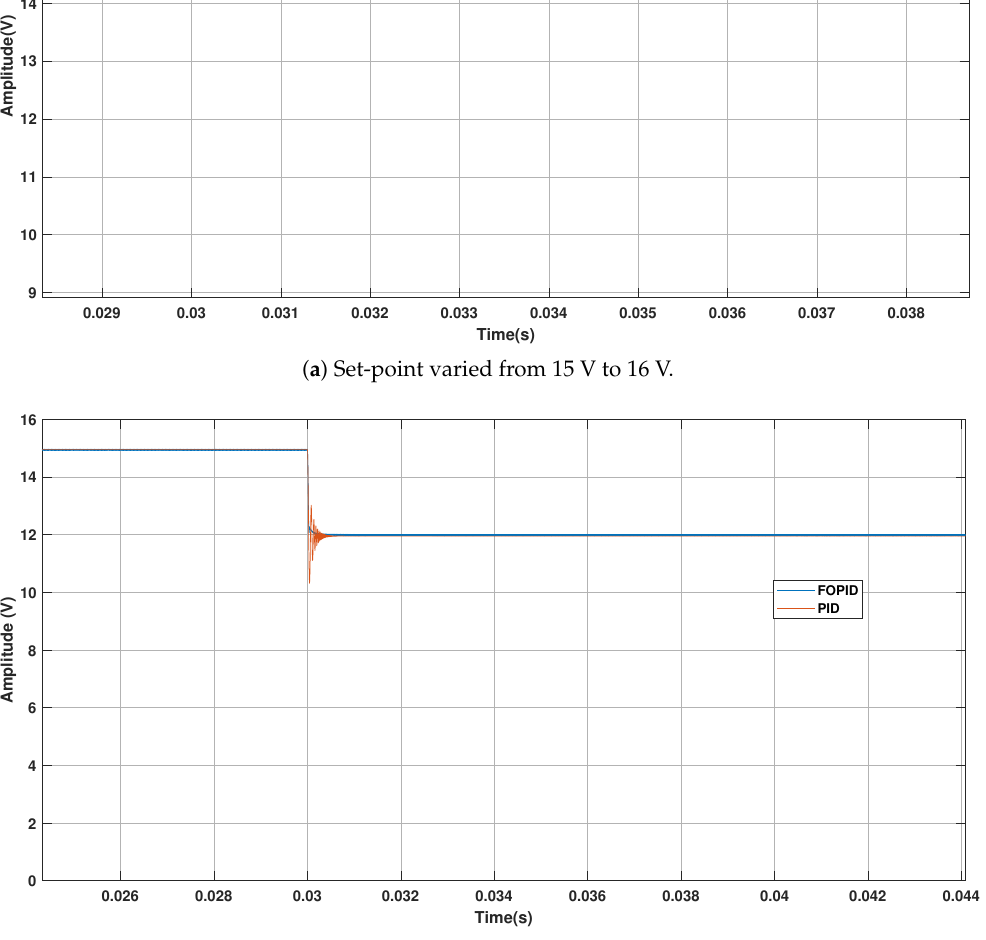
( b ) Set-point reduced from 15 V to 12 V. Figure 10. Response of the FOPID and PID controllers to set-point